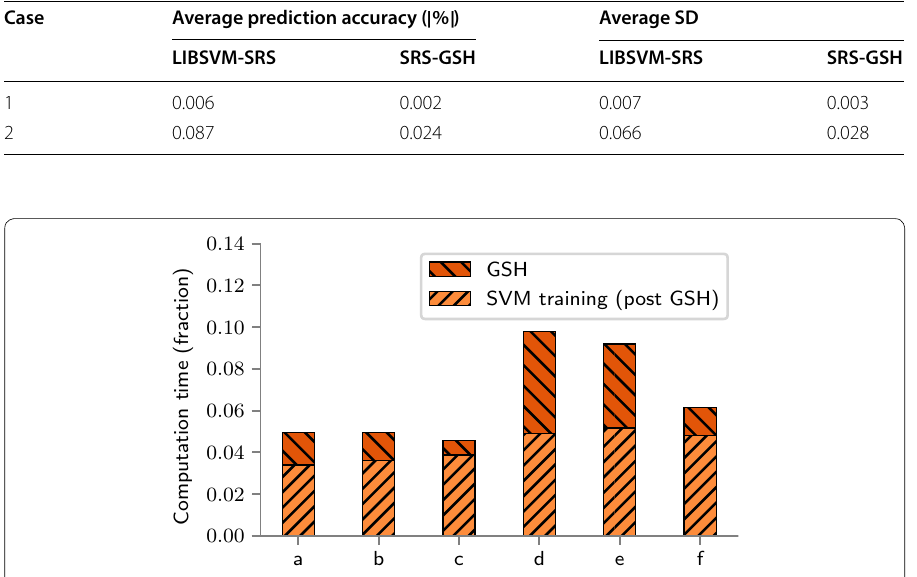
Fig. 19 Fraction of LIBSVM training time. a – c is for C-SVM, whereas d – f is for nu-SVM with linear, polynomial, and rbf kernels,